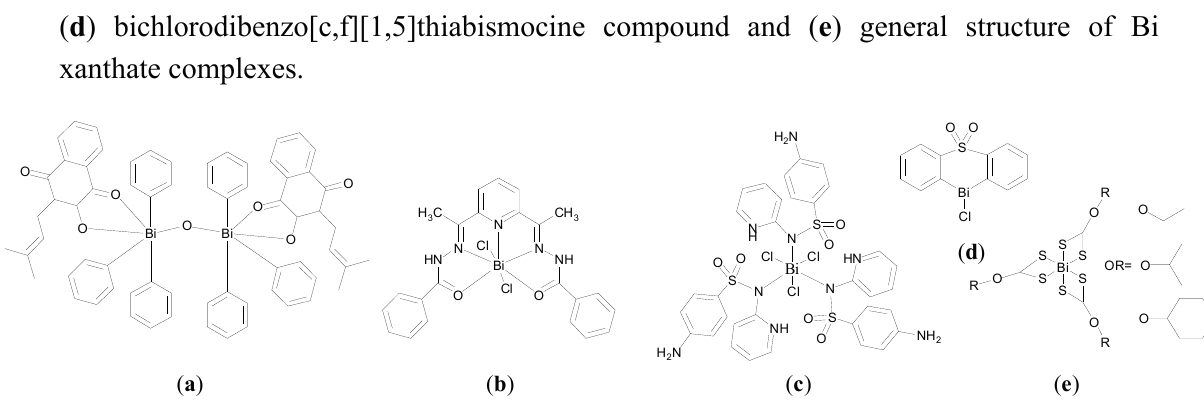
Figure 19. Structure of ( a ) (Lp) 2 (Ph 3 Bi) 2 O, ( b ) [Bi(HAcPh)Cl 2 ], ( c ) [BiCl 3 (Spy) 3